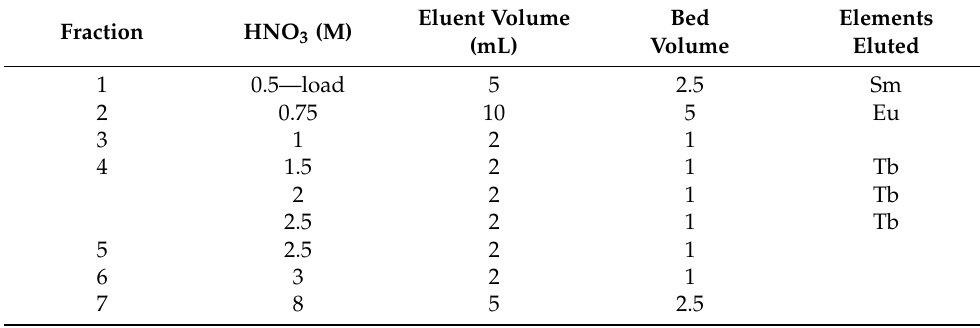
Table 2. Gradient elution parameters for Tb purification using a second separation with 0.78 g LN resin with 50–100 µ m particle